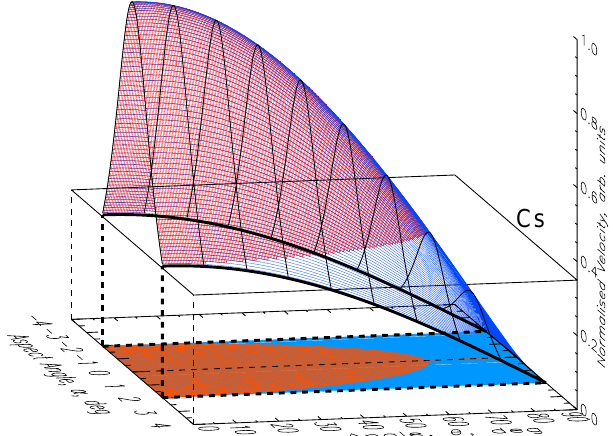
Fig. 4. Surfaces of the phase velocity model dependence upon the flow and aspect angles. The red (blue) surface shows the model as- suming that the phase velocity reaches minimum at the ion-acoustic speed C s (cosine component of the ion-acoustic speed C s cos θ ) represented by the plane (thick